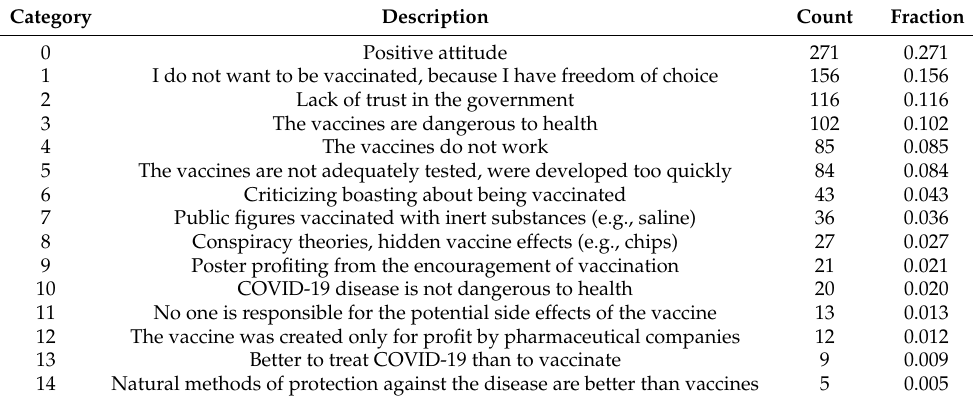
Table 2. Categories of COVID-19 vaccine-related comments on social media platforms.